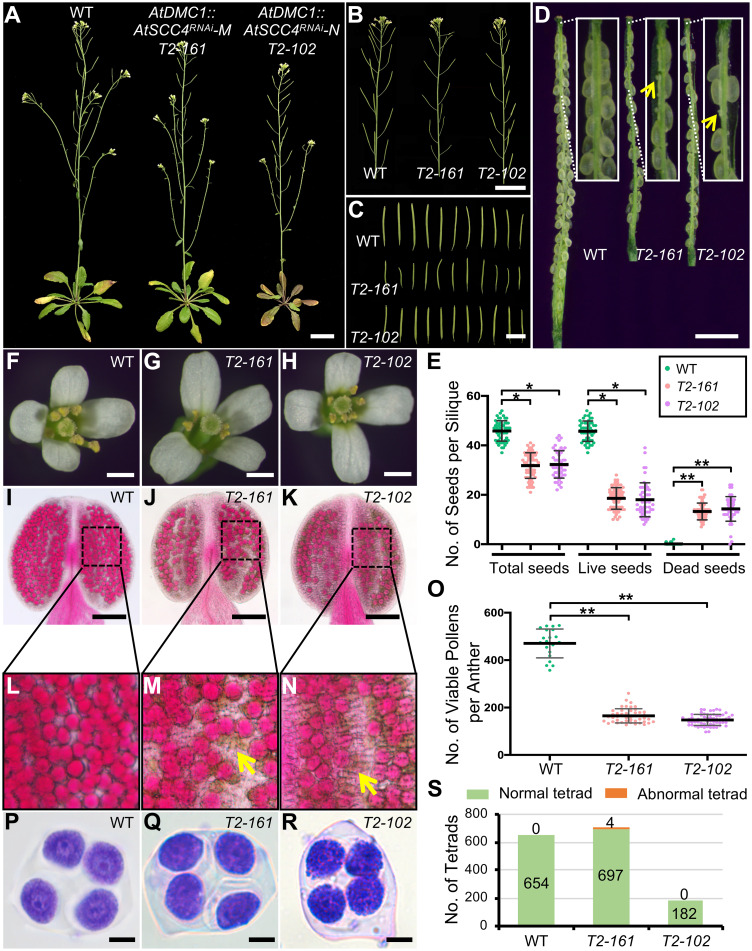
AtDMC1::AtSCC4RNAi transgenic plants have reduced fertility.(A) WT, AtDMC1::AtSCC4RNAi-M T2-161 and AtDMC1::AtSCC4RNAi-N T2-102 (M and N refer the fragments used for the construction of RNAi plasmids) plants. Bar = 3 cm. (B) Primary stems of WT, T2-161 and T2-102. Bar = 3 cm. (C) Siliques of WT, T2-161 and T2-102. Bar = 1 cm. (D) Stripped siliques of WT, T2-161 and T2-102. Yellow arrows indicate undeveloped embryos. Bar = 1 mm. (E) Plots of total seeds, live seeds and dead seeds in WT, T2-161 and T2-102 (* P < 0.05 or ** P < 0.01, the significance of reduced seed number in AtSCC4RNAi transgenic plants versus WT, by two-tailed Student’s t test; each dot represents the number of seeds in one silique). (F-H) Open flowers of WT, T2-161 and T2-102. Bar = 1 mm. (I-K) Alexander staining of WT, T2-161 and T2-102 anthers. Bar = 100 μm. (L-N) Zoom-in of WT, T2-161 and T2-102 pollens. (O) Plots of viable pollen in WT, T2-161 and T2-102 (** P < 0.01, the significance of reduced pollen number in AtSCC4RNAi transgenic plants versus WT, by two-tailed Student’s t test; each dot represents the number of pollen in one anther). (P-Q) Toluidine blue dye staining of WT, T2-161 and T2-102 tetrad-stage microspores. Bar = 100 μm. (S) Plots of normal and abnormal tetrad-stage microspores in WT, T2-161 and T2-102.